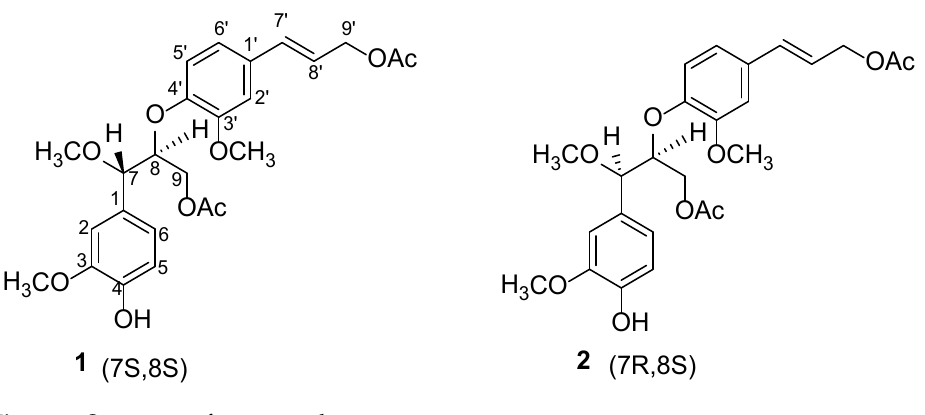
Table 1. The 1 H (600 MHz) and 13 C NMR (150 MHz) data for 1 , 2 in CDCl 3 .